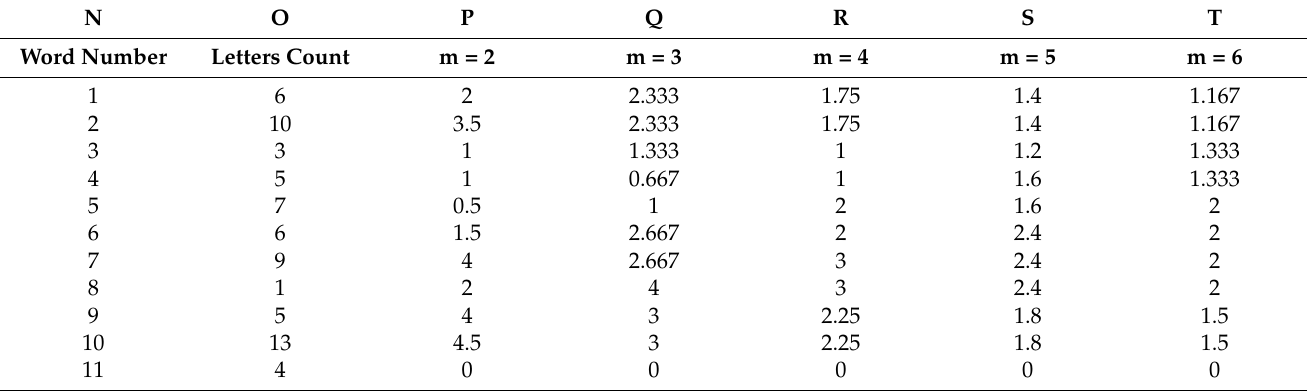
Table 1. The relationship between the number of cells in the grid covering the sequence graph and the cell size of the grid. N